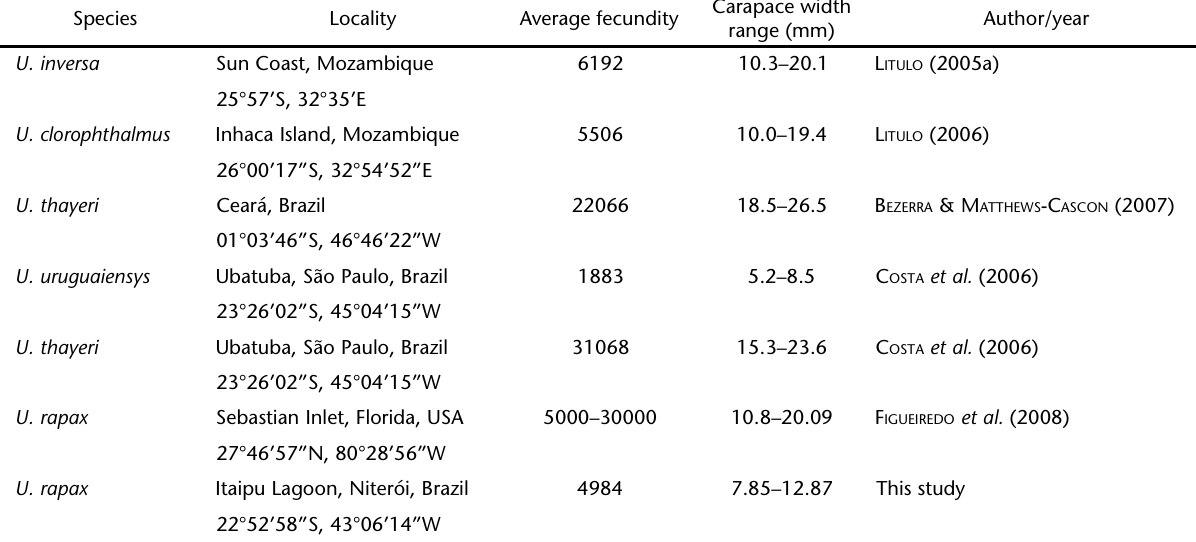
Table VI. Average fecundity and carapace width range in several Uca species.